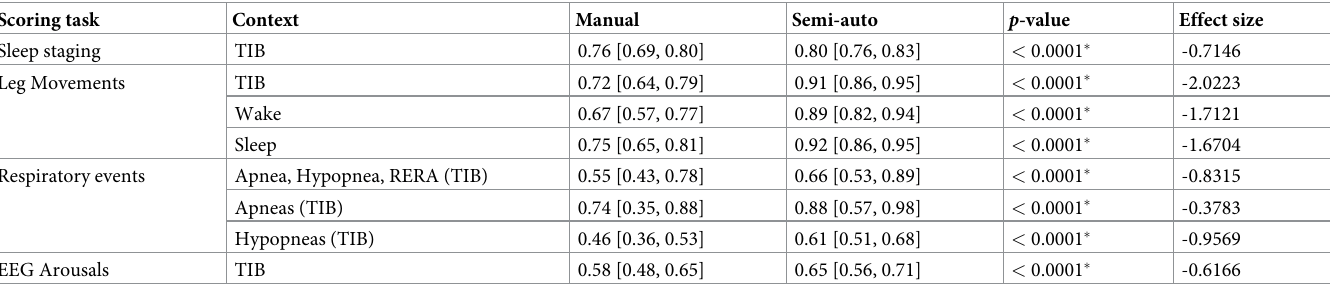
Table 3. Overall kappa inter-scorer agreement per scoring task and comparison between manual and semi-automatic approaches. Scoring